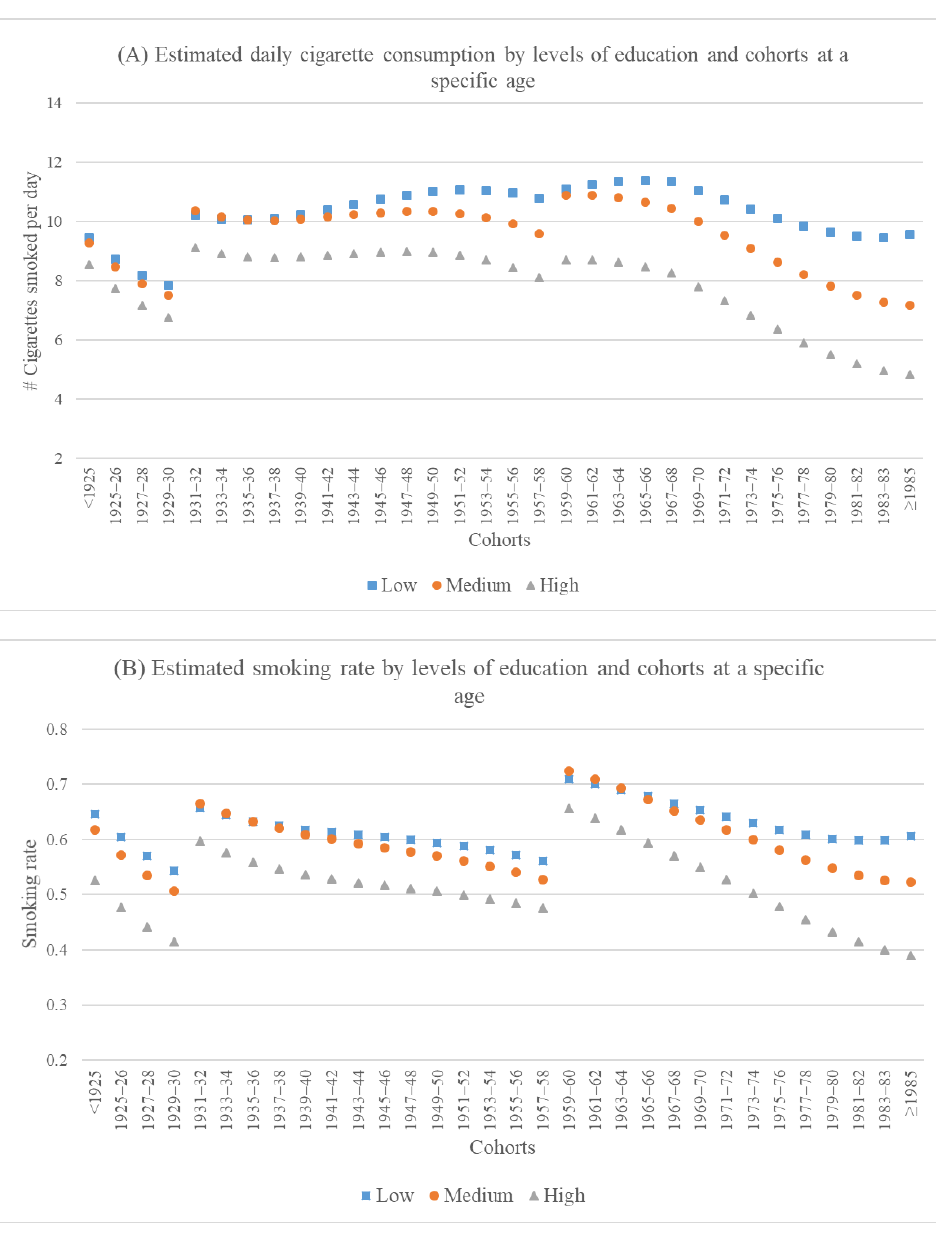
Figure 2. Cohort differences in educational gaps in smoking behavior. Note 1: The prediction is based on Models 3 and 6 in Table 2. Note 2: We display estimated smoking behavior at a specific age so as to present inter-cohort changes in educational gaps in smoking holding age constant. However, since the study period (1991–2015) covers different age ranges for different cohorts, we cannot find a single age that is covered by the study period for all cohorts. We therefore displayed estimated smoking behavior at 30 years for cohorts born on or after 1959, 58 years for those born between 1931 and 1958, and 68 years for those born on or before 1930. The age points are chosen to maximize the cohorts they intersect